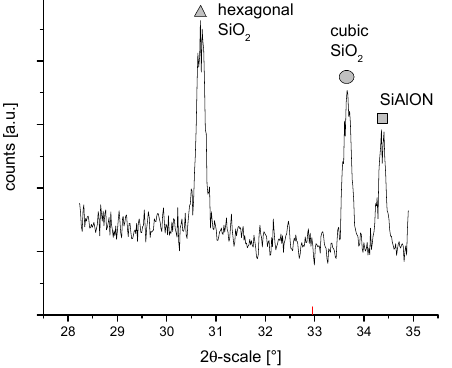
Figure 3. Magnified detail XRD pattern of alumina sample—Al 2 O 3 _450 between 29–35°.